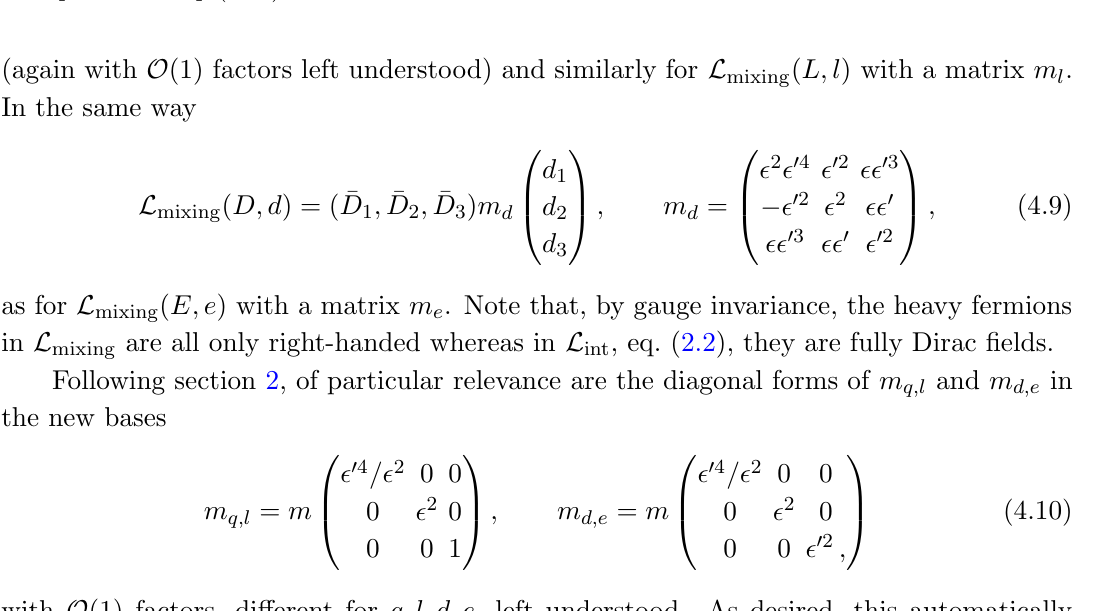
Table 3 . Transformation properties under SU(2) F (cid:2) U(1) F of the heavy fermions, grouped in SU(4) multiplets as in eq.